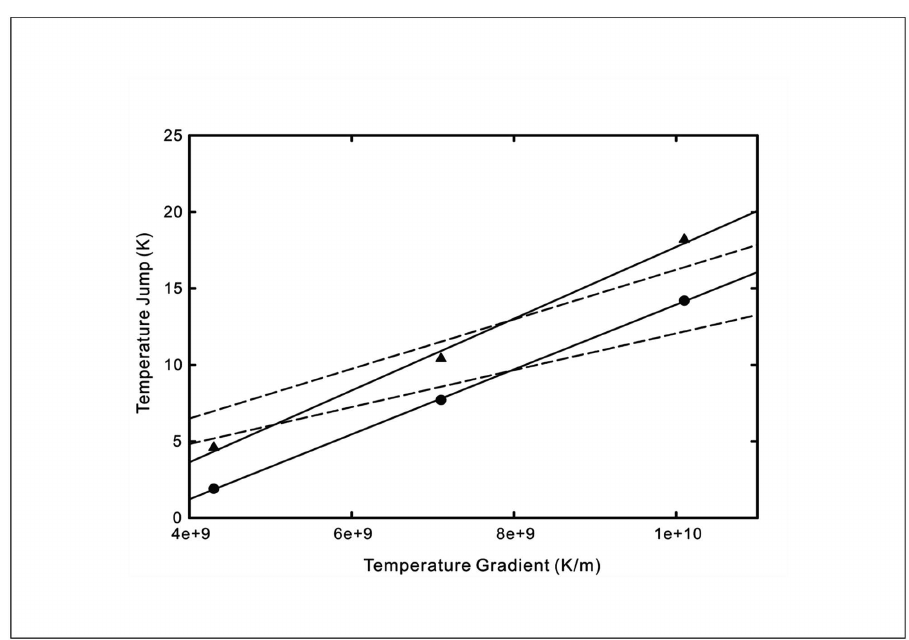
Fig 5. Temperature jump as a function of wall temperature gradient at a solid-liquid argon interface. Symbols: MD simulation results at T w = 160 K (triangles), T w = 90 K (circles) [15]. Solid line: New temperature jump model from Eq 8 with C 1 = 2.348 × 10 − 9 and C 2 = 0.036 for T w = 160 K , C 1 = 2.121 × 10 − 9 and C 2 = 0.081 for T w = 90 K . Dashed line: Existing temperature jump model from Eq 11 with C = 1.623 × 10 − 9 for T w = 160 K , C = 1.207 × 10 − 9 for T w = 90 K .